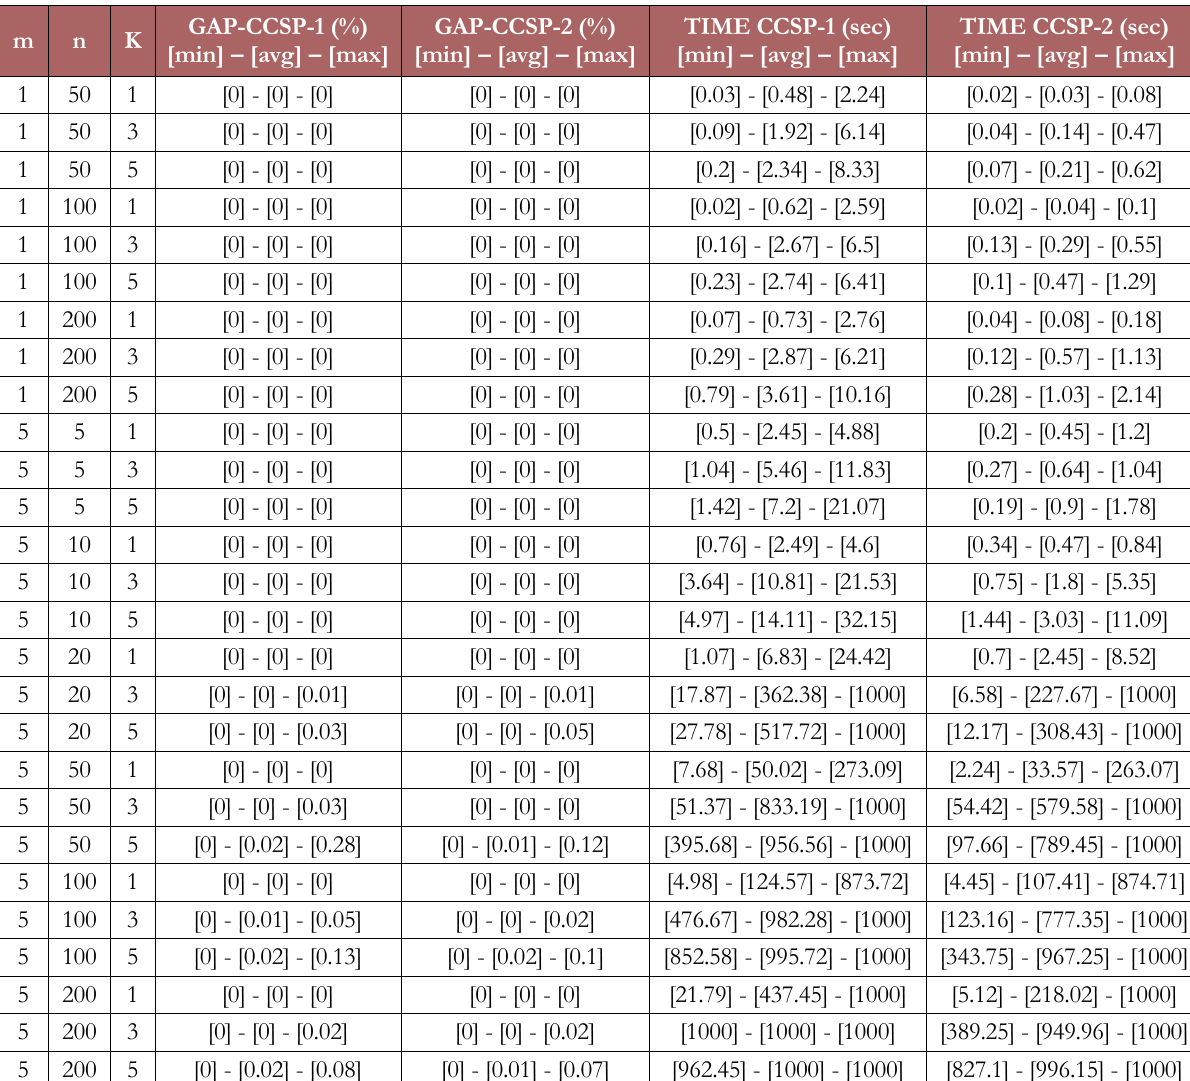
Table 3. Results of the computational experiment